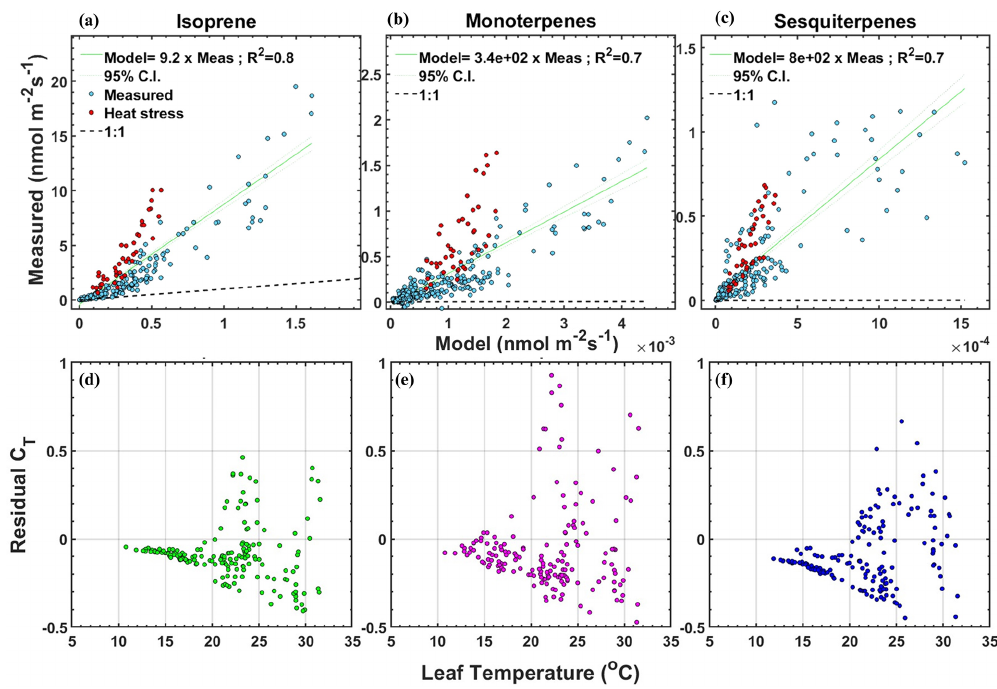
Figure 4. Measured vs. MEGANv2.1 emission for (a) isoprene, (b) MTs, and (c) SQTs of data points that passed EC quality criteria. The red color-coded data points are the flux measurements after 22 June 2021 and are included in the fits. Residual C T (measured C T – MEGANv2.1 C T ) of (d) isoprene, (e) MTs, and (f) SQTs vs. leaf temperature of data points that passed EC quality criteria and that have PAR > 1000µmolm − 2 s − 1 for the whole